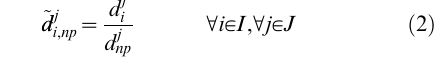
relative to. In terms of random variables, the ~ dd j